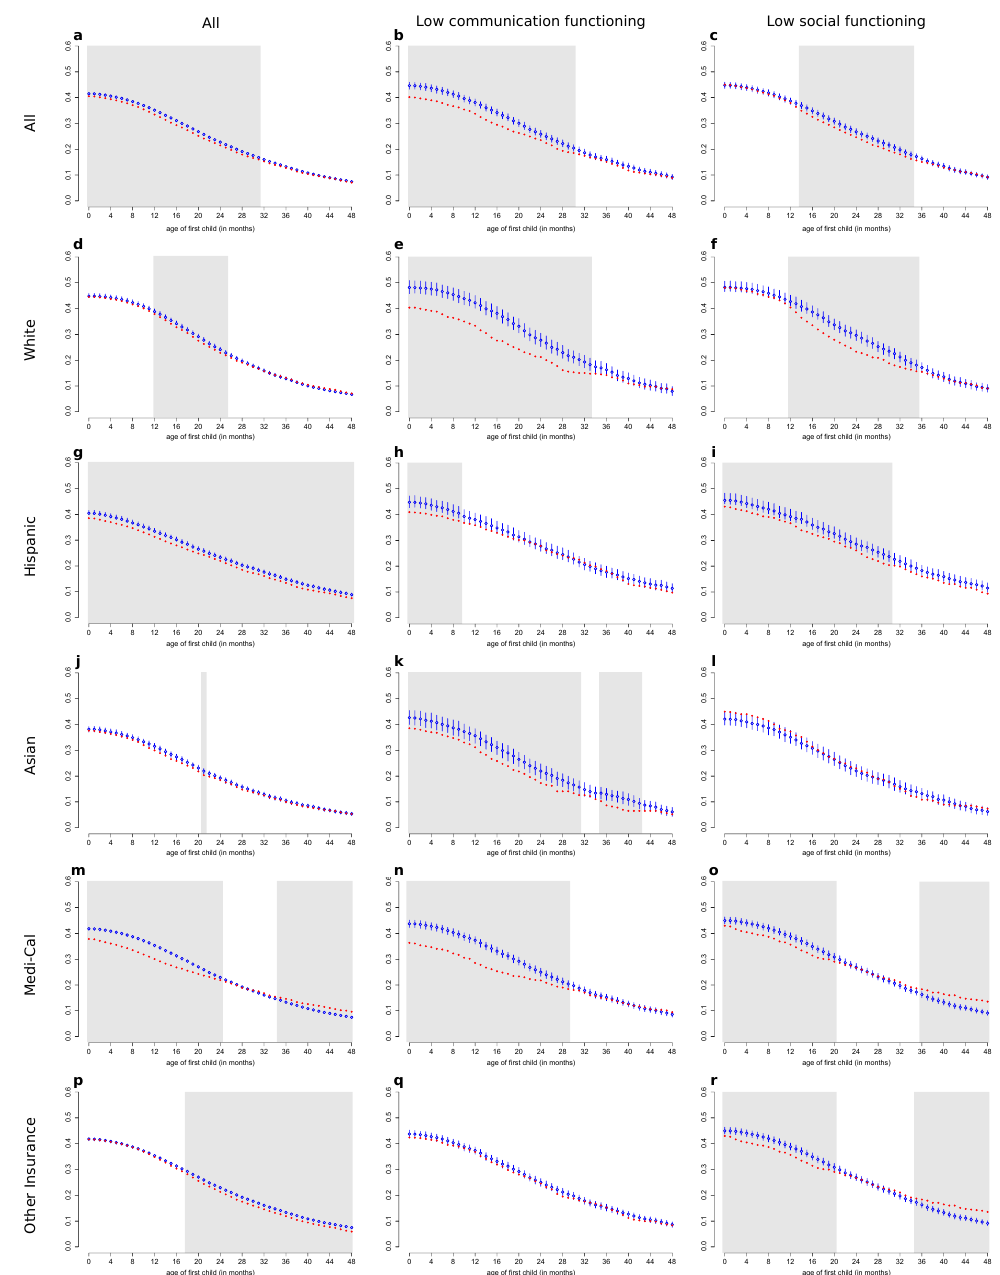
Figure 4: Proportion of mothers of firstborn children with (solid red circles) and without (open blue circles) autism who conceived a subsequent child at each given age of the first child, relative to those who have yet to conceive a second child, stratified by severity group, the race/ethnicity of the mother, and the type of insurance used to pay for delivery. Shaded areas indicate significant effects of the first child’s autism status on subsequent fertility.